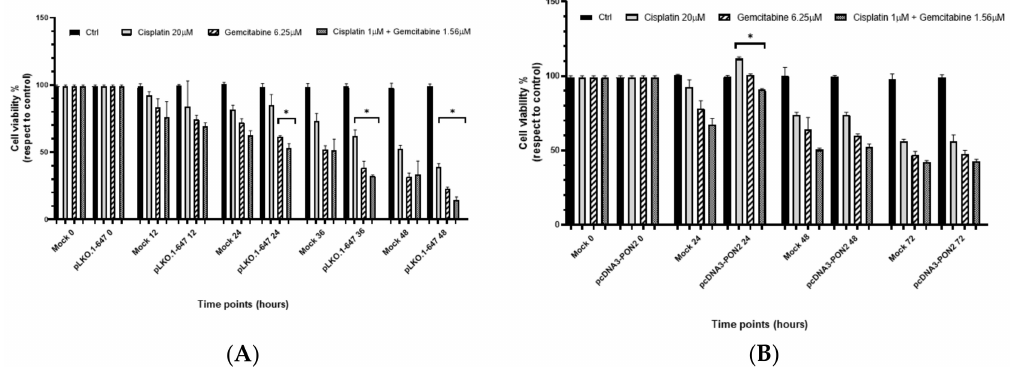
Figure 4. E ff ect of chemotherapeutic drugs on the proliferation of T24 cells. The MTT assay was performed to evaluate the influence of treatment with cisplatin (20 µ M), gemcitabine (6.25 µ M), or both compounds (cisplatin 1 µ M + gemcitabine 1.56 µ M) on the viability of cells transfected with pLKO.1-647 (panel A ) or pcDNA3-PON2 (panel B ) compared with controls (mock). Determination of the proliferative rate was carried out at di ff erent time points (0, 12, 24, 36, 48, and 72 h). All values are expressed as the mean ± standard deviation (* p <